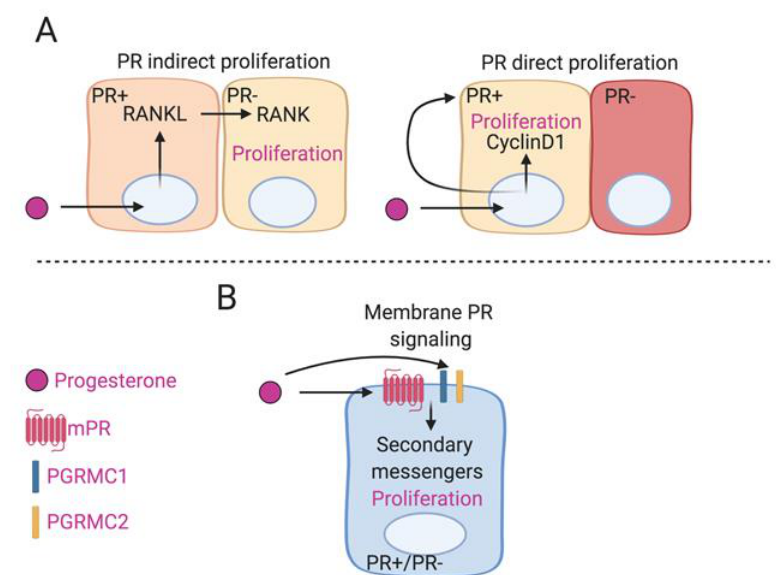
Figure 2. Progesterone-induced mammary proliferation by classical and non-signaling. ( A ) The majority of the mammary gland consists of PR negative luminal epithelial cells. However, progesterone is capable of inducing sustained proliferation of PR-negative luminal epithelial cells by indirect paracrine signaling whereby PR-positive cells upregulate RANKL and act on RANK in PR-negative adjacent cells. PR-positive cells can also exhibit progesterone induced proliferation by self-intrinsic activation of cyclinD1 via autocrine signaling. ( B ) Progesterone-induced mammary proliferation by non-classical signaling. Progesterone can act on a variety of membrane progesterone receptors such as mPRs, PGRMC1 and PGRMC2 that can activate secondary messengers and promote the proliferation of either PR-positive or PR-negative mammary cells. Figure 2 was created using